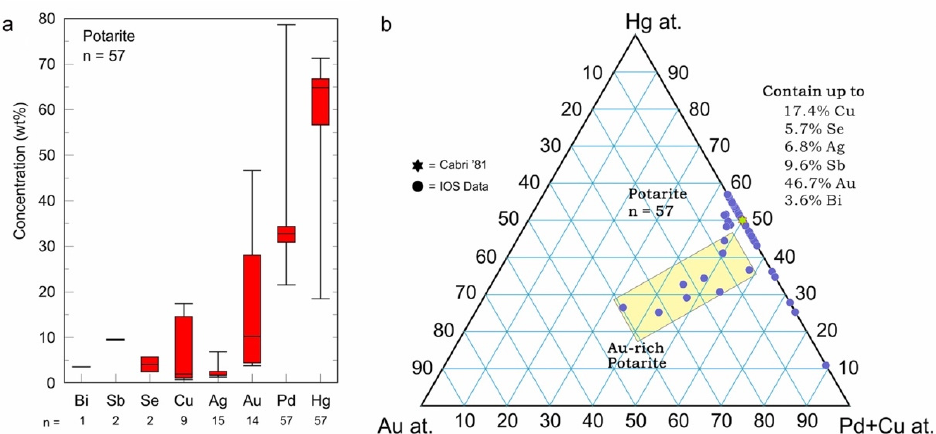
Figure 14. The compositional variation of 57 potarite grains is illustrated in ( a ) box and whisker plot, and ( b ) an Au at.–Hg at.–Pd + Cu at. ternary diagram. Whiskers represent the range of minimum and maximum values. The short line within each box represents the median value, which separates the box into two parts (i.e., lower 25th–50th percentile group and upper 50th–75th percentile). The n below the axis: number of grains containing the element of interest. The colored polygon in b limits the field for Au-rich potarite. The elemental values in b are presented in atomic proportions (at.). Data from Cabri [25] have been included in b to be compared with data from this study.